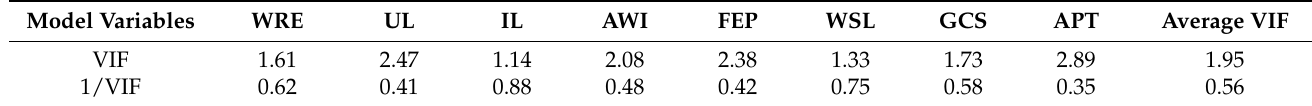
Table 3. Results of multicollinearity